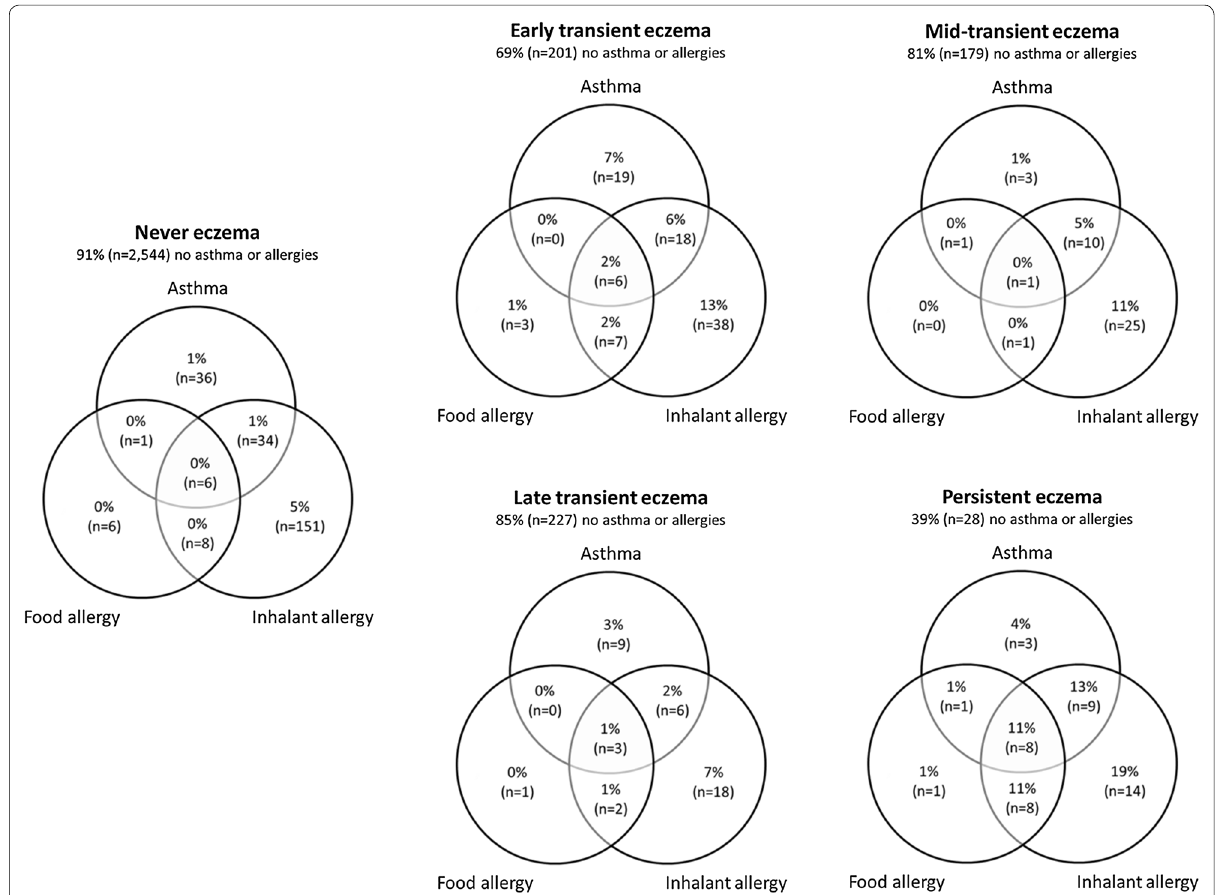
Fig. 1 Prevalence of current asthma, physician diagnosed food and inhalant allergy in eczema phenotype. Values are percentages (absolute values) and based on observed data. n number of participants with information on current asthma or physician diagnosed allergies, and at least 3 = eczema measurements